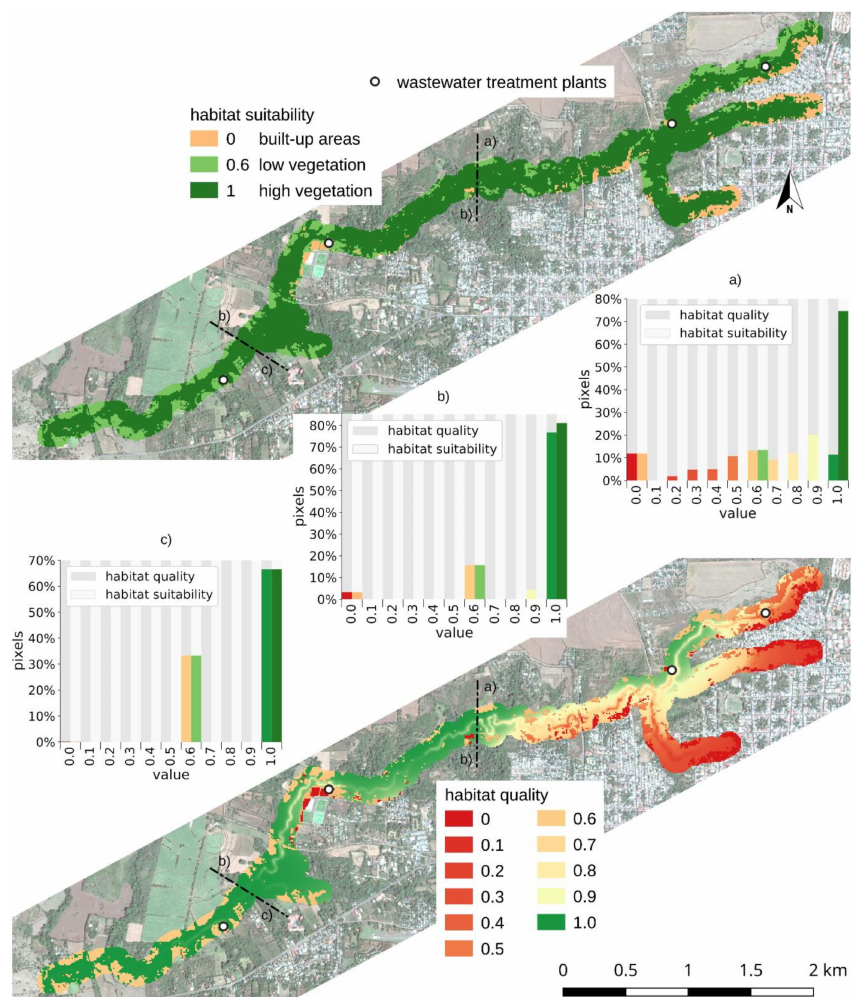
Figure 8. Habitat suitability map (top) and habitat quality map (bottom) resulting from the application of threats (Table 2). Histograms in the middle illustrate pixel distributions of the three river corridors sections with very high ( a ), moderate ( b ), and very low habitat degradation levels ( c